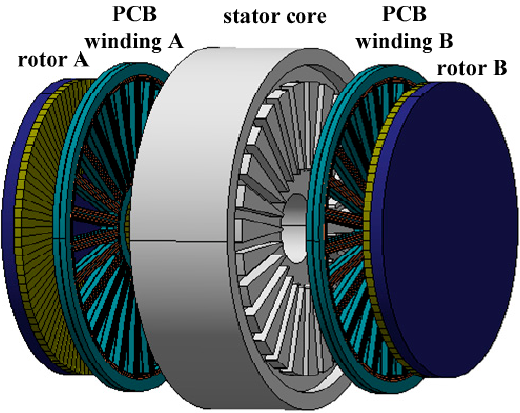
Figure 7. 3D view of the axial-flux permanent-magnet machine (AFPM) with a PCB stator and teeth.